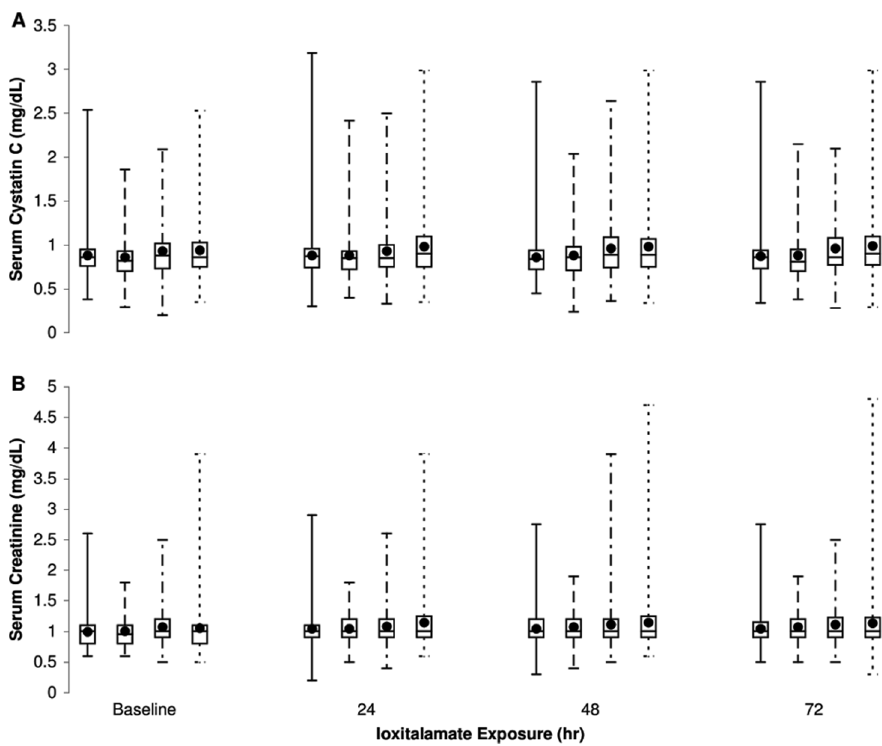
Figure 2. Change in serum creatinine and cystatin C levels of 500 outpatients exposed to ioxitalamate. Mean of serum creatinine (panel A) and serum cystatin C (panel B) concentrations before (baseline) and after administration of ioxitalamate, according to treatment group. Treatments: NAC (N-acetylcysteine plus saline; group 1), NaHCO3 (sodium bicarbonate plus saline; group 2), NAC + NaHCO3 (N-acetylcysteine plus sodium bicarbonate plus saline; group 3), saline (group 4). Means among the treatment groups did not differ significantly. Error bars indicate 1 standard deviation about the mean.